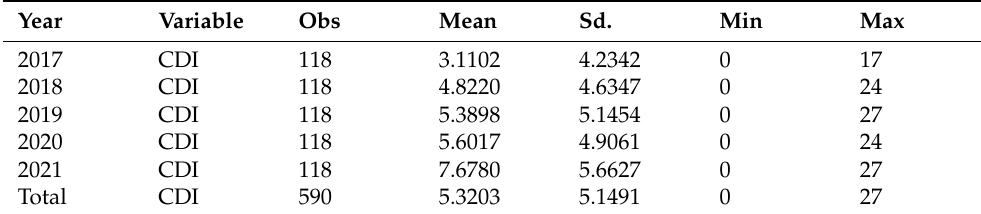
Table 3. Basic statistics on the quality of carbon information